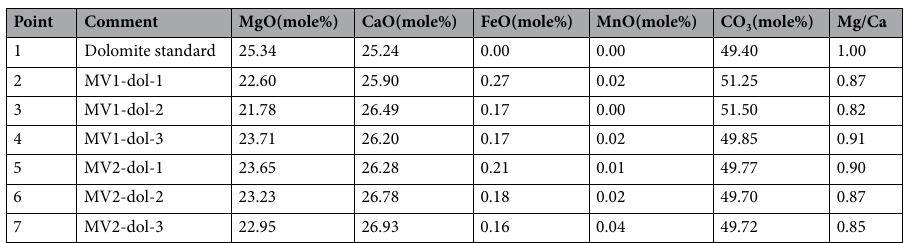
Table 2. Results of dolomite stoichiometry inferred from single point analyses from EPMA data. Elemental compositions are in mole% calibrated to standard dolomite. Traces of Fe and Mn are constituents of dolomite.